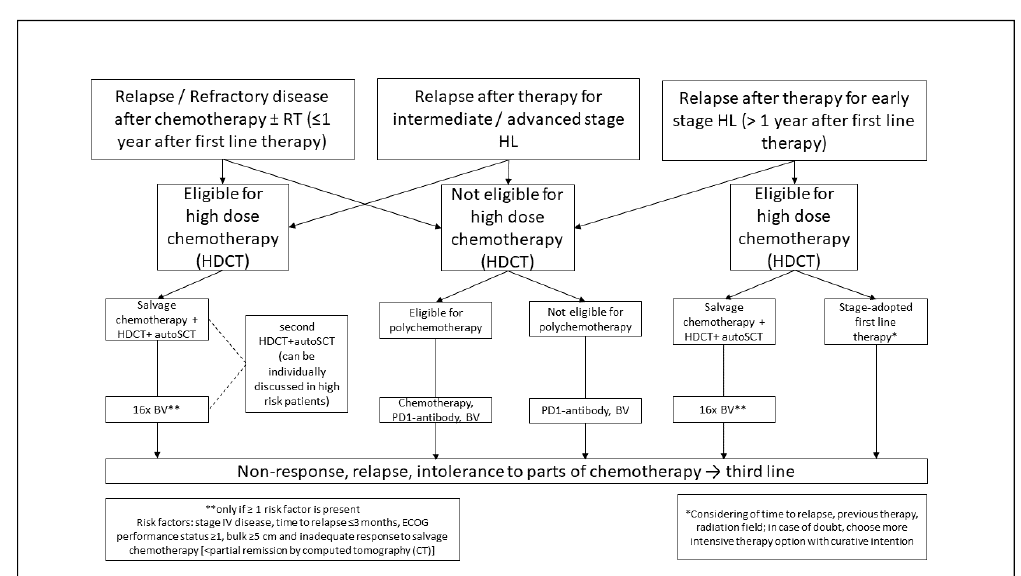
Figure 3. Therapy algorithm for relapsed/refractory HL.